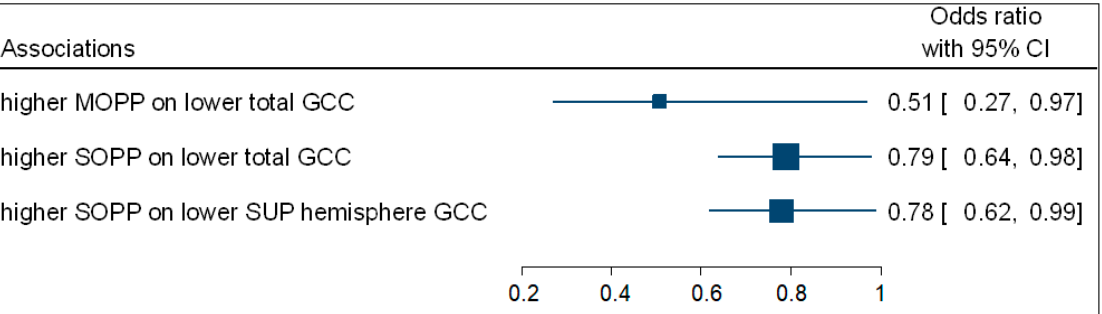
Figure 4. A forest plot showing associations between OPP and macula GCC.